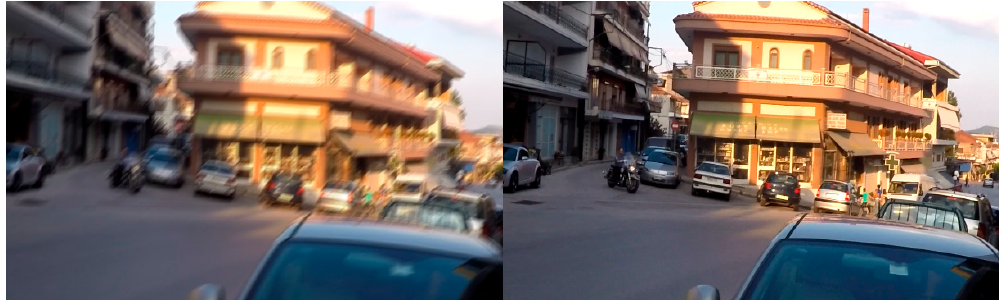
Figure 1. Blurred and sharp image of GOPRO